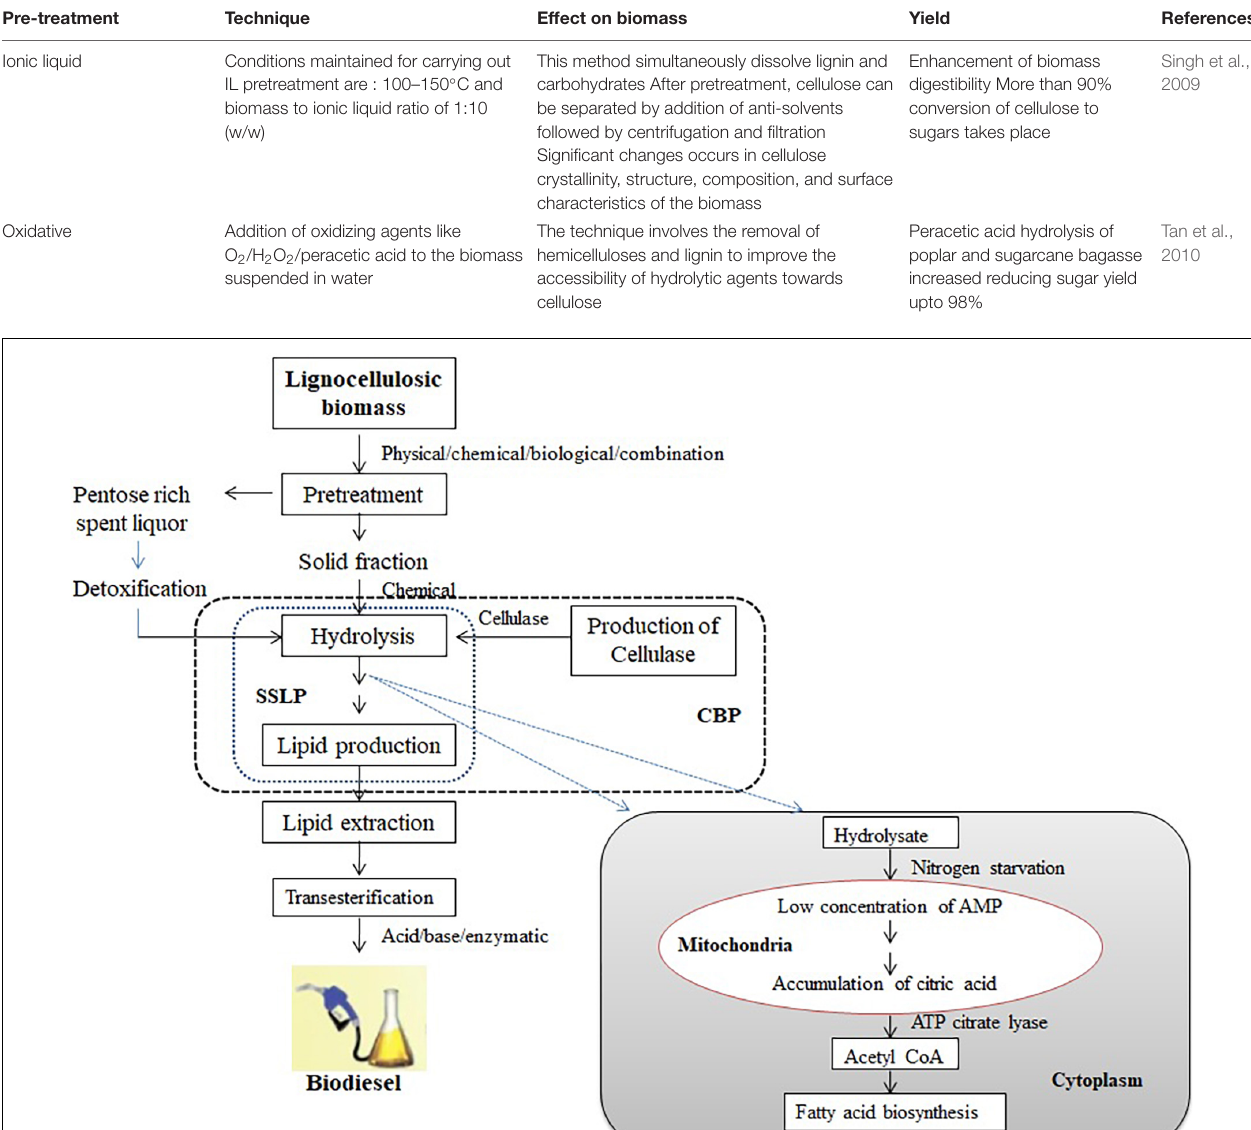
order to make the process economical, green solvent and green extraction techniques that can save time and energy and reduce solvent consumption are being used (Kumar et al.,